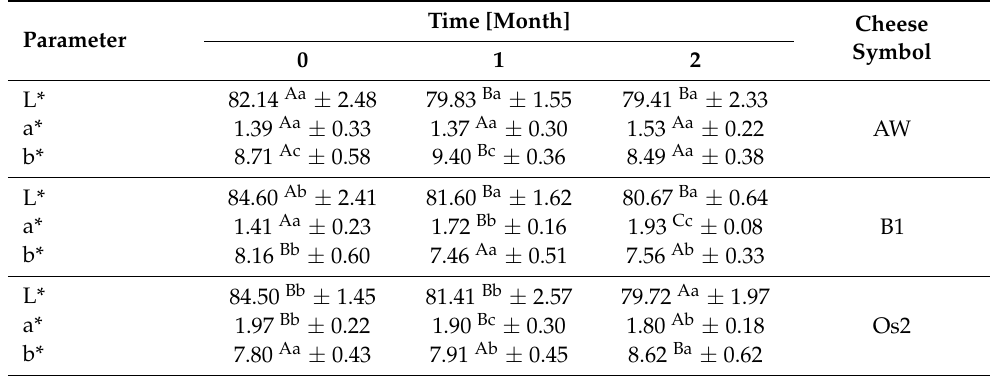
Time [Month] Cheese